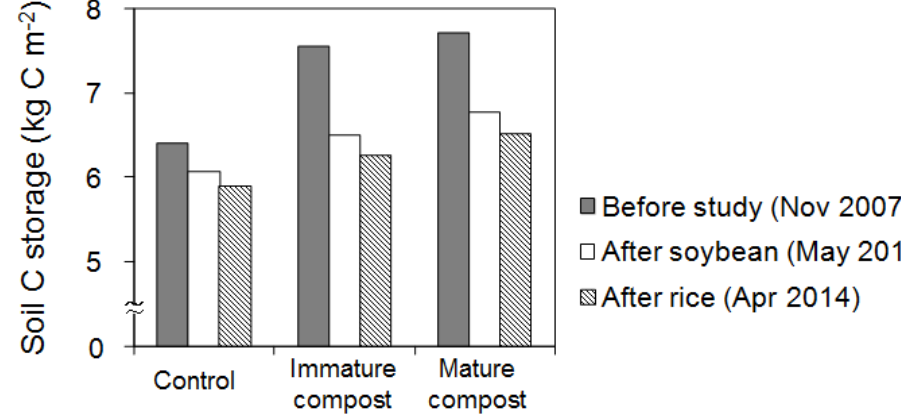
Figure 4. Decrease in soil carbon (C) storage (0–30 cm) under the soybean–rice cultivation.